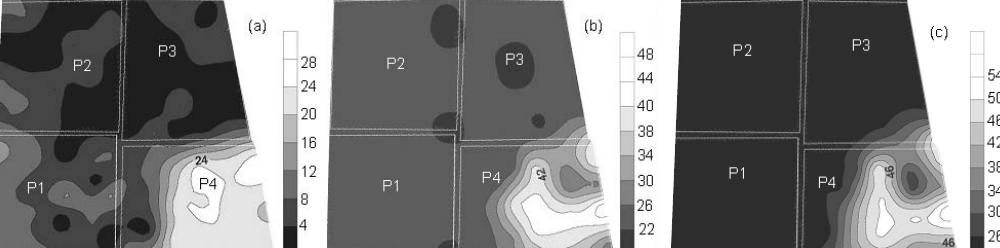
Figura 3. Mapas de contorno do teor de argila de solos das parcelas experimentais da PIF coco, Frutese, Platô de Neópolis, SE, em que P1, P2, P3 e P4 são, respectivamente, as parcelas 1, 2, 3 e 4: (a) % de argila na profundidade de 0–20 cm; (b) % de argila na profundidade de 20–40 cm; e (c) % de argila na profundidade de 100–120